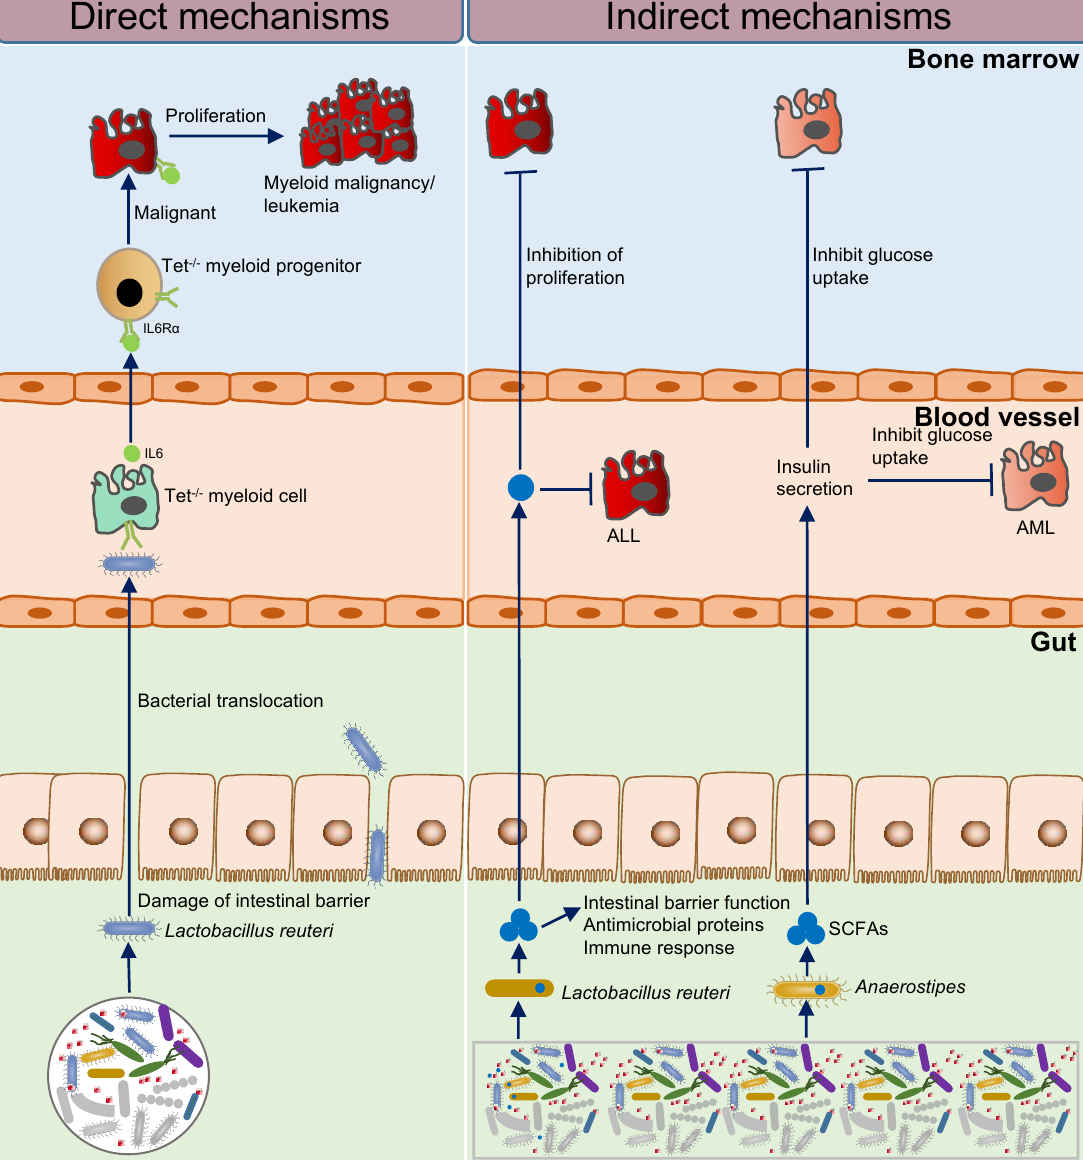
Figure 1. The mechanism of intestinal microbes affecting the initiation and progression of